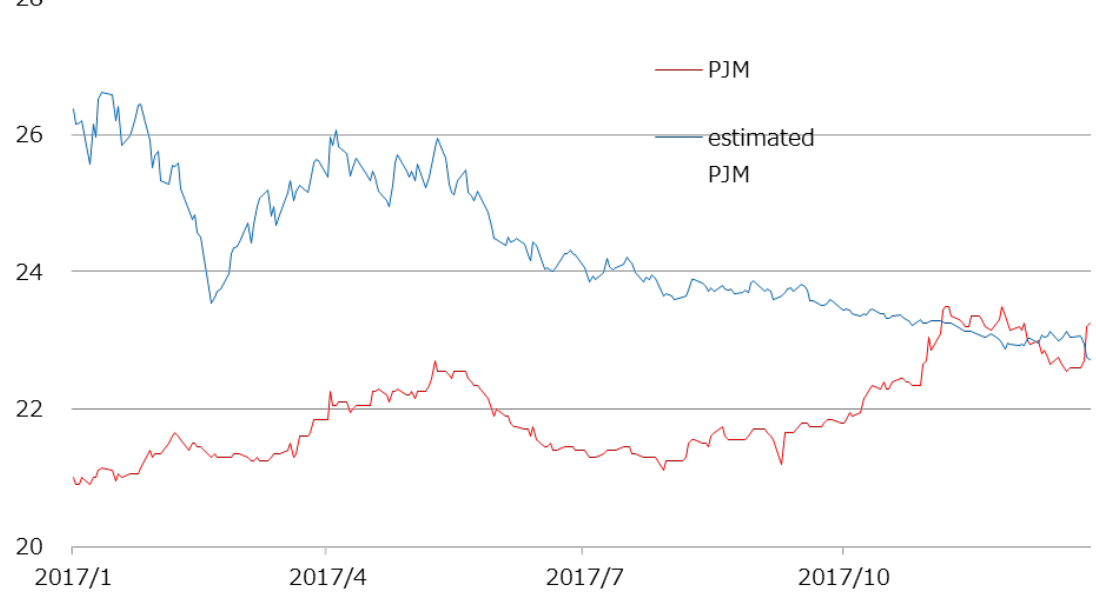
Figure 5. Coefficients of equilibrium equation.